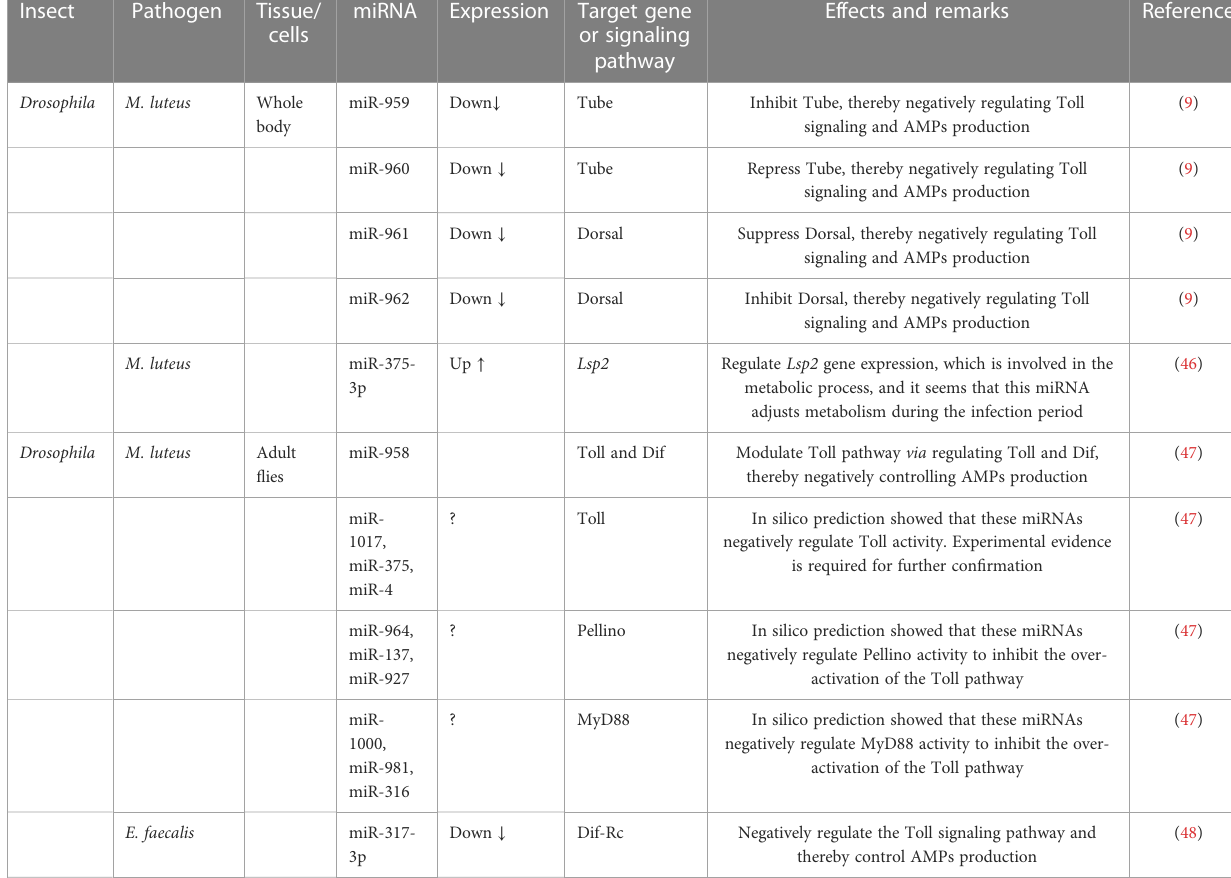
TABLE 1 miRNAs that play a biological role in the immune responses of insects to bacterial pathogens.